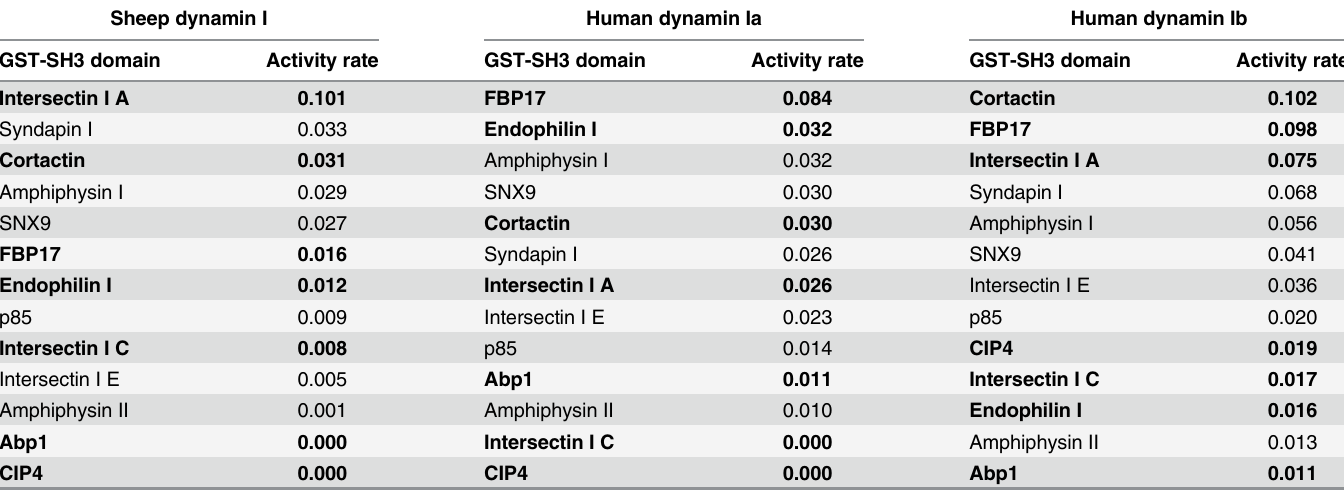
Table 2. Rank order analysis of the stimulation of the activity of endogenous sheep dynamin I (from Fig 1B) and single splice variants human dynamin Iab and Ibb (Fig 2A) by 13 GST-SH3 domains. Sheep dynamin I Human dynamin Ia Human dynamin